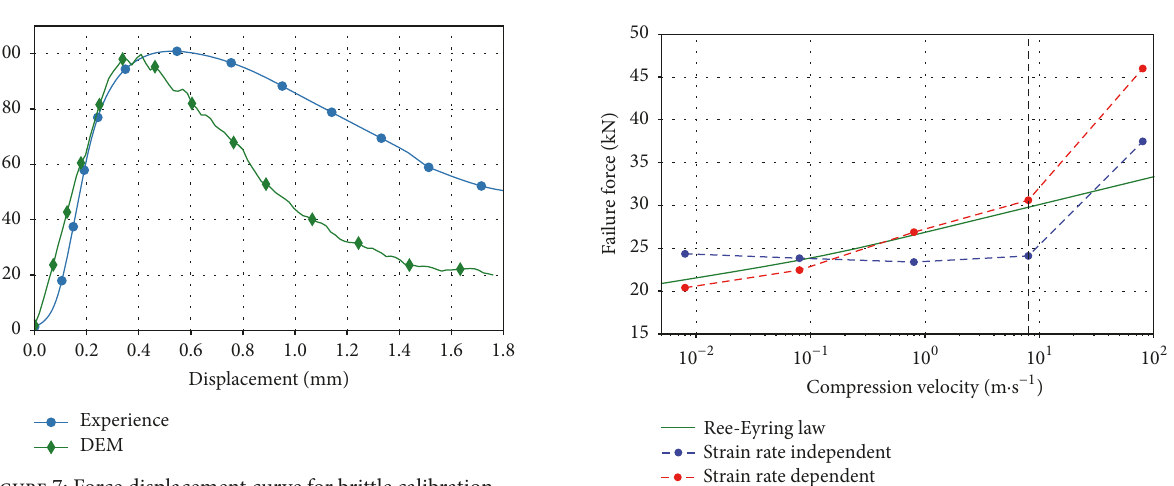
Figure 7: Force displacement curve for brittle calibration.